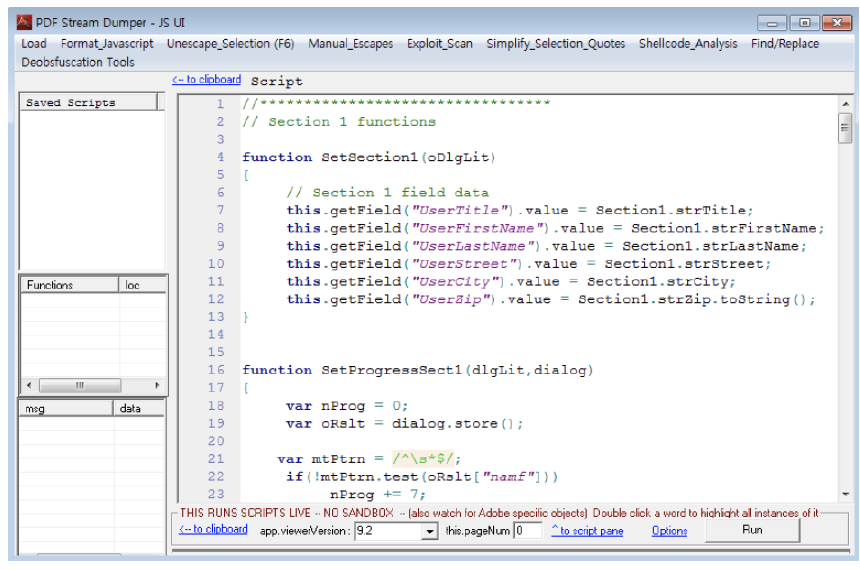
Figure 8. Object 141 decoded by PDFStreamDumper.